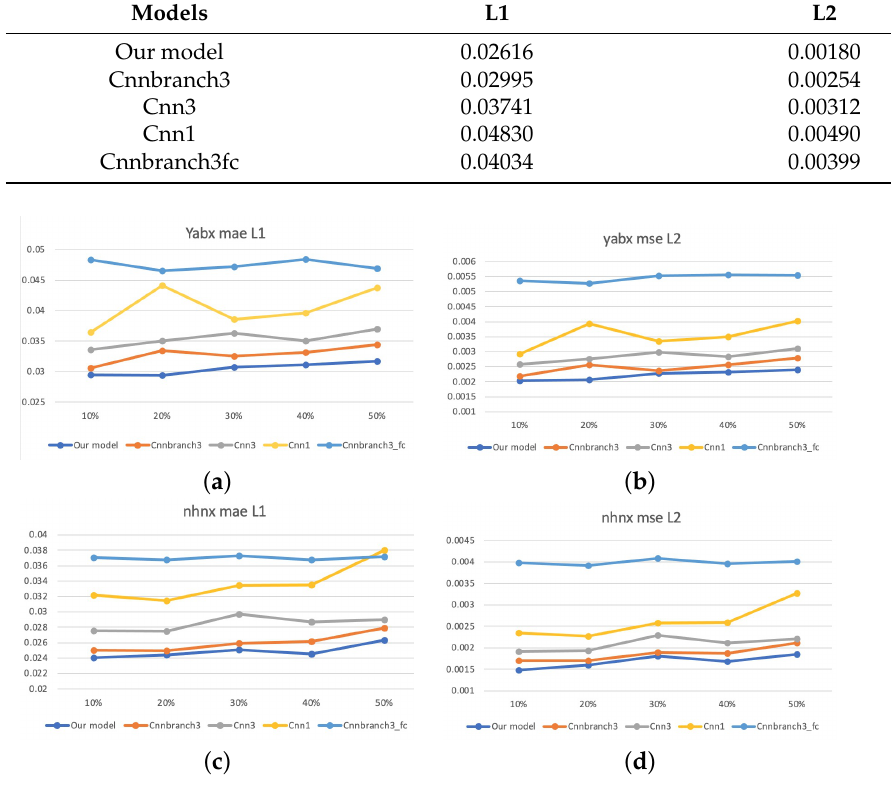
Figure 17. Results of different levels of damage on two elevated highways. ( a ) L1 of different levels of damage on Yan’an elevated highways. ( b ) L2 of different levels of damage on Yan’an elevated highways. ( c ) L1 of different levels of damage on Neihuan elevated highways. ( d ) L2 of